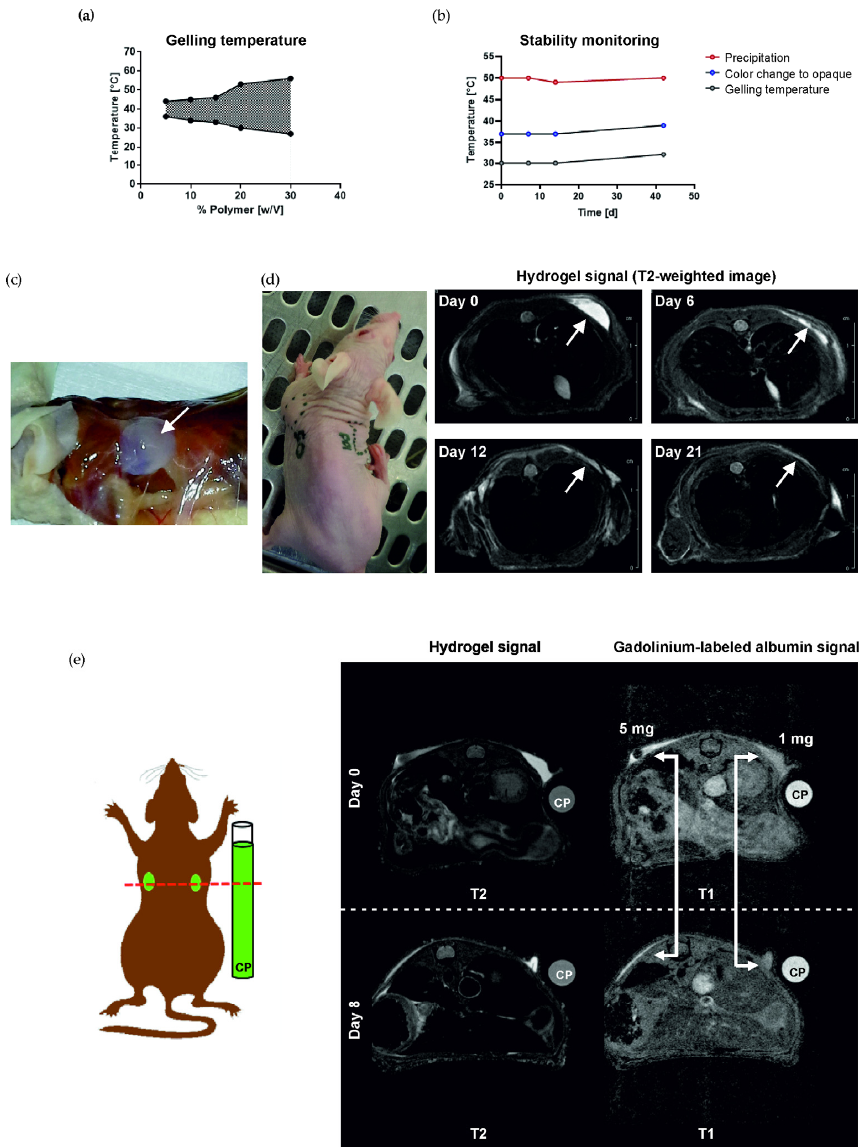
Figure 1. Stability monitoring, depot formation, and biodegradability of hydrogel. ( a ) Gelling behavior of hydrogel solutions with a polymer content of 5, 10, 15, 20, and 30% ( w/v ). ( b ) Stability monitoring of hydrogel over a period of 6 weeks. ( c ) Depot formation 2 h after injection of 100 µL hydrogel (s.c.). ( d ) MRI monitoring of the degradation of a 100 µL hydrogel depot. Images were taken directly after injection as well as on days 6, 12, and 21. ( e ) MRI monitoring of gadolinium- labeled albumin, injected with hydrogel directly after injection and on day 8. White arrows indicate the location of the hydrogel depot. CP, cylinder phantom with hydrogel loaded with gadolinium- labeled albumin; T1, T1-weighted; T2, T2-weighted.